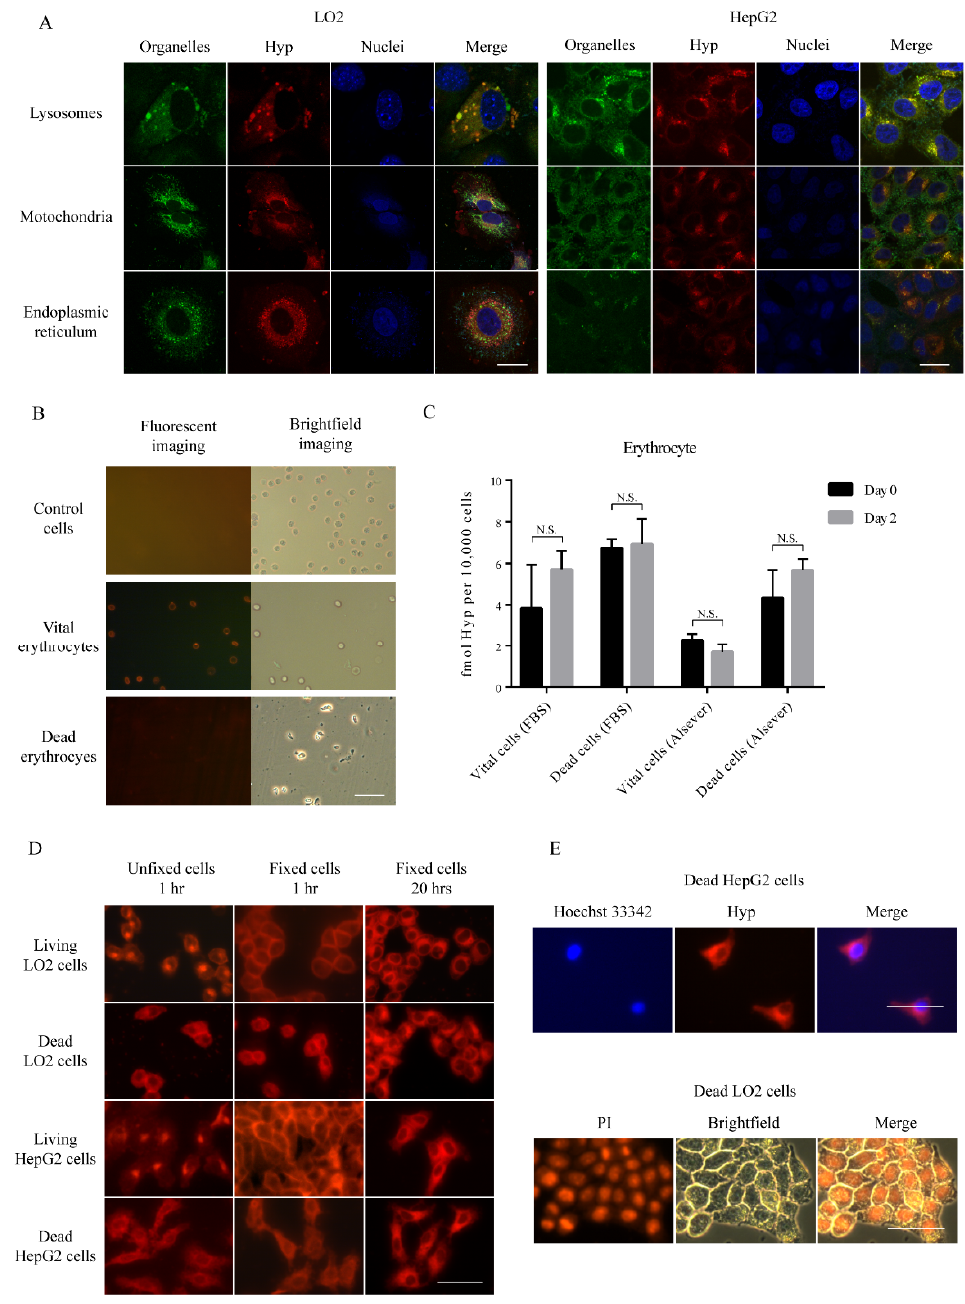
Figure 4. Subcellular localization of Hyp: ( A ) Fluorescence confocal microscopy of subcellular localization of Hyp in vital cells. Scale bar = 20 µ m. ( B ) Visualization of erythrocytes under ultraviolet light or white light. Scale bar = 50 µ m. ( C ) Comparison of concentration of Hyp in day zero and day two in erythrocytes. Data are expressed as the mean ± standard error (N = 3). ( D ) Subcellular localization of Hyp in fixed vital or dead cells. Scale bar = 50 µ m. ( E ) Representative images of dead cells after staining for DNA by Hoechst 33342 and propidium Iodide (PI) or after incubating with Hyp.